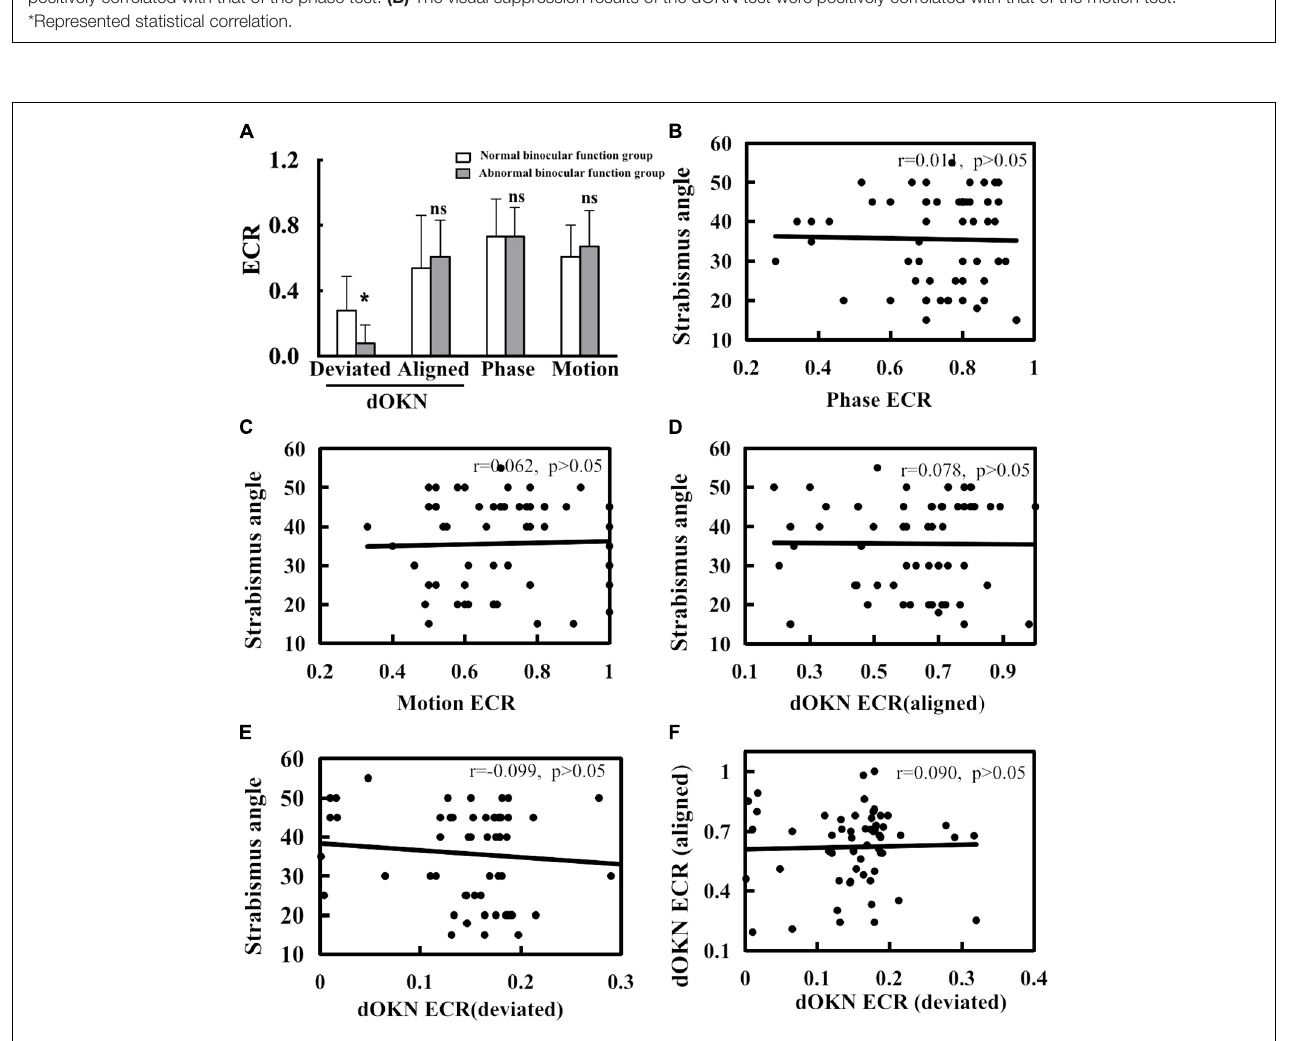
FIGURE 7 | Correlation of visual suppression and strabismus angle. (A) When deviation was shown, a significant difference in dOKN results was observed between the normal binocular function (NBF) group and the abnormal binocular function (ABF) group. (B) No significant correlation exists between deviation angle and visual suppression measured by phase test. (C) No significant correlation exists between deviation angle and visual suppression measured by motion test. (D) No significant correlation exists between deviation angle and visual suppression measured by the dOKN test when kept aligned. (E) No significant correlation exists between deviation angle and visual suppression measured by the dOKN test when deviation shows. (F) No significant correlation exists in between the dOKN ECR measured under alignment state with that under the deviation state. *Represents statistical difference. Neither phase nor motion test could reflect this discrepancy.